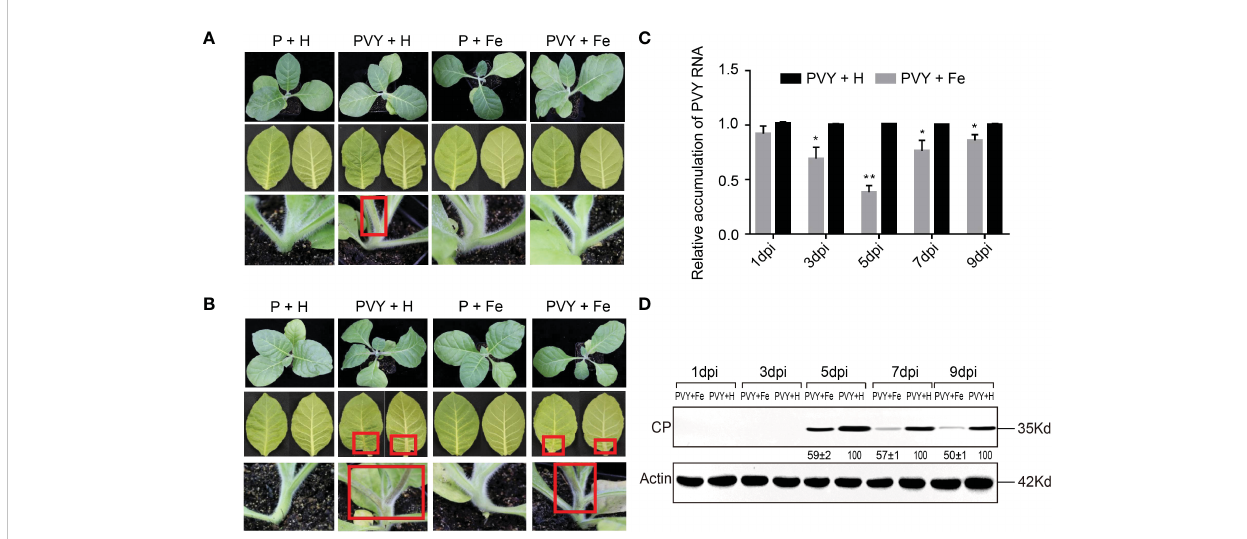
FIGURE 1 Foliar application of exogenous Fe alleviated PVY infection in tobacco plants. (A) Symptoms of the whole plant, leaves and stems at 7 dpi in four treatments. (B) Symptoms of the whole plant, leaves and stems at 9 dpi in four treatments. (C) The accumulation of PVY genomic RNA in tobacco leaves of PVY + H and PVY + Fe groups determined by RT-qPCR at 1, 3, 5, 7, and 9 dpi. Asterisks indicate statistically signi fi cant differences compared to control (Student ’ s t -test): * P < 0.05, ** P < 0.01. (D) The accumulation of PVY CP protein in tobacco leaves of PVY + H and PVY + Fe groups determined by western blot assays at 1, 3, 5, 7, and 9